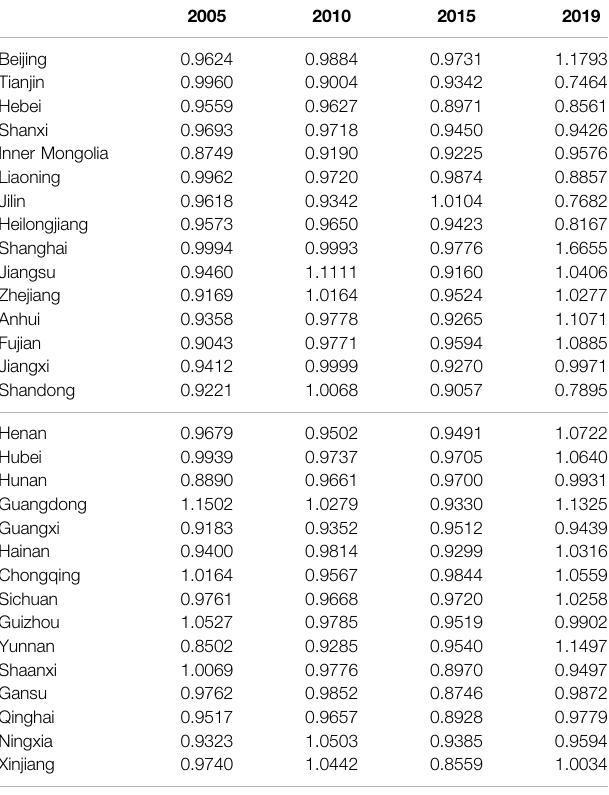
TABLE 3 | Results of green total factor productivity